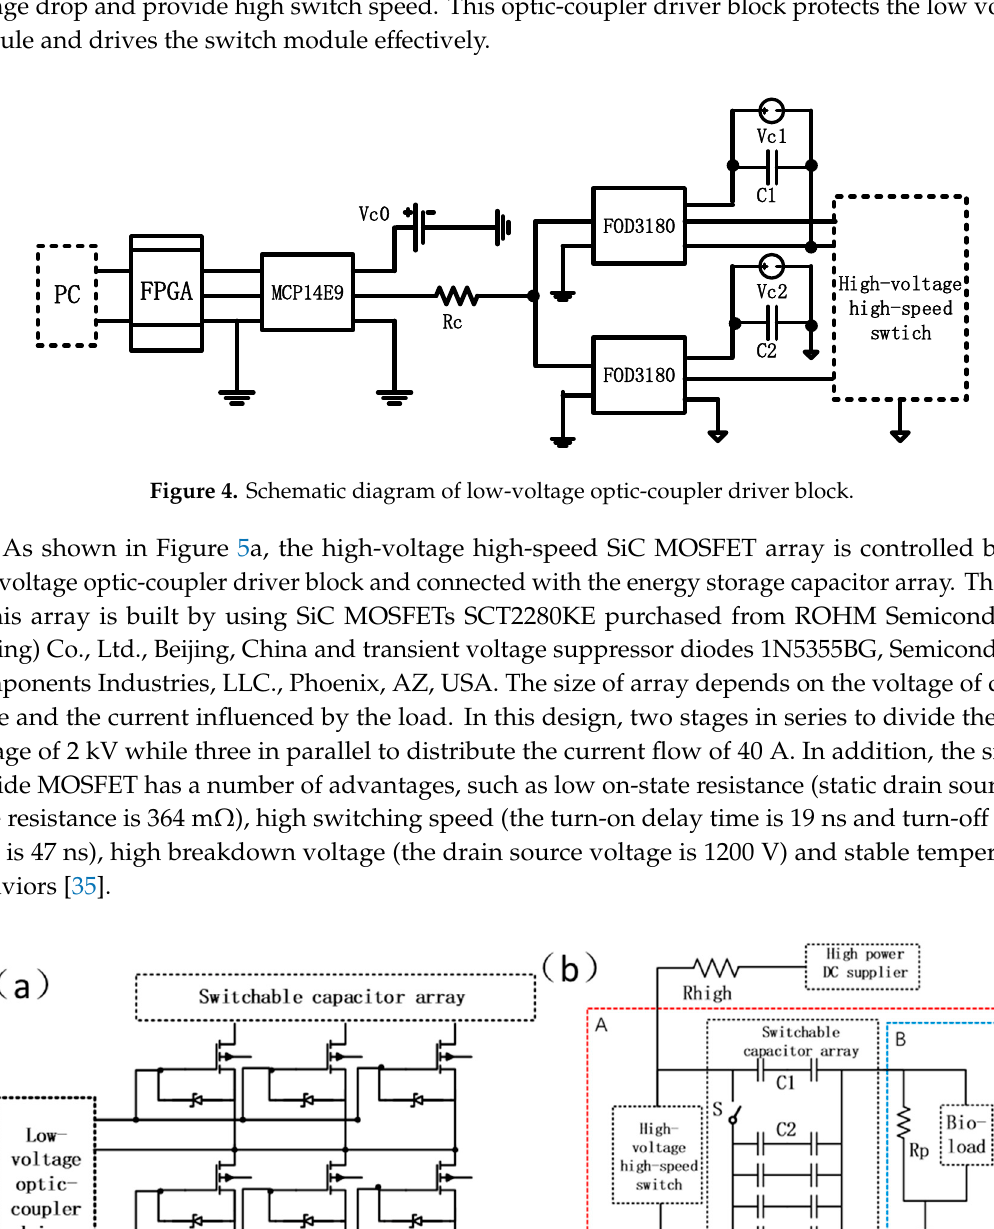
Figure 5. Schematic diagram of ( a ) the high-voltage high-speed switch, and ( b ) switchable capacitor array and the operation of the pulse generator.